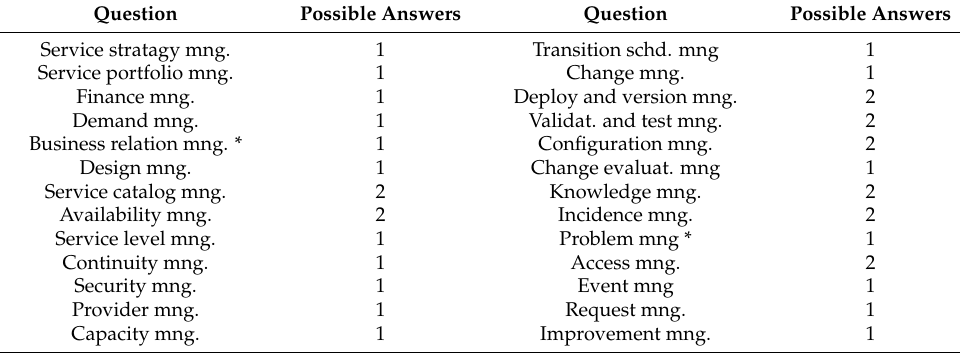
Table A2. Answers to the survey collected from the example company.